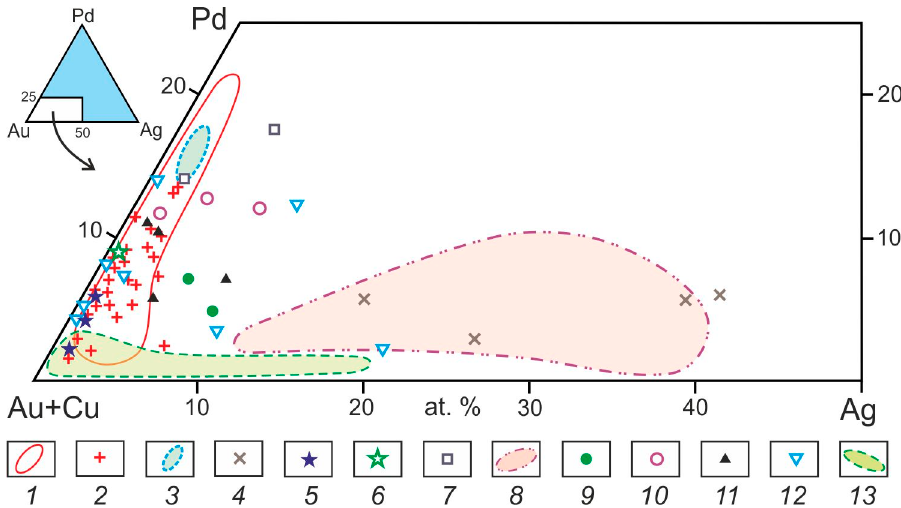
Figure 5. Diagram of palladium gold compositions: 1—Mayat river placer [19]; 2—Bolshaya